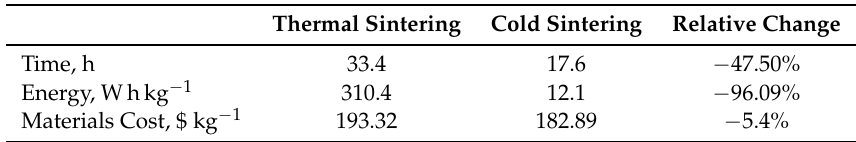
Table 3. Comparison of the time, energy, and materials cost needed to manufacture monolithic Zn foam electrodes using thermal sintering and cold sintering processes. Thermal Sintering Cold Sintering Relative Change Time, h